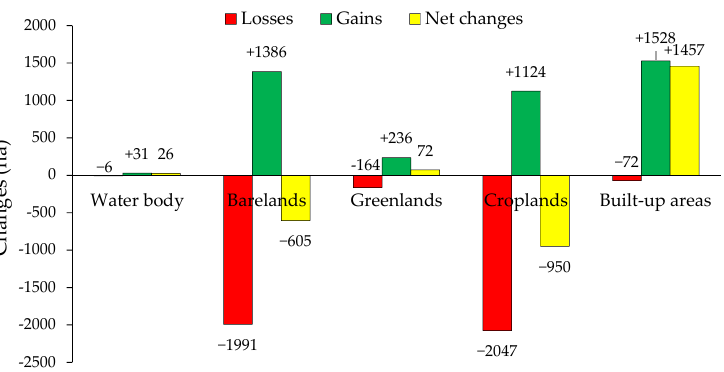
Figure 6. Gains (+), losses ( − ) and net changes for each land use/cover class (ha) for the period of 2000 − 2020. As shown in Figure 6, the comparison of the net change of croplands during the studied period indicates that the area covered by croplands decreased by 950 ha. The net changes in the built-up areas were +1457 ha during 2000–2020.